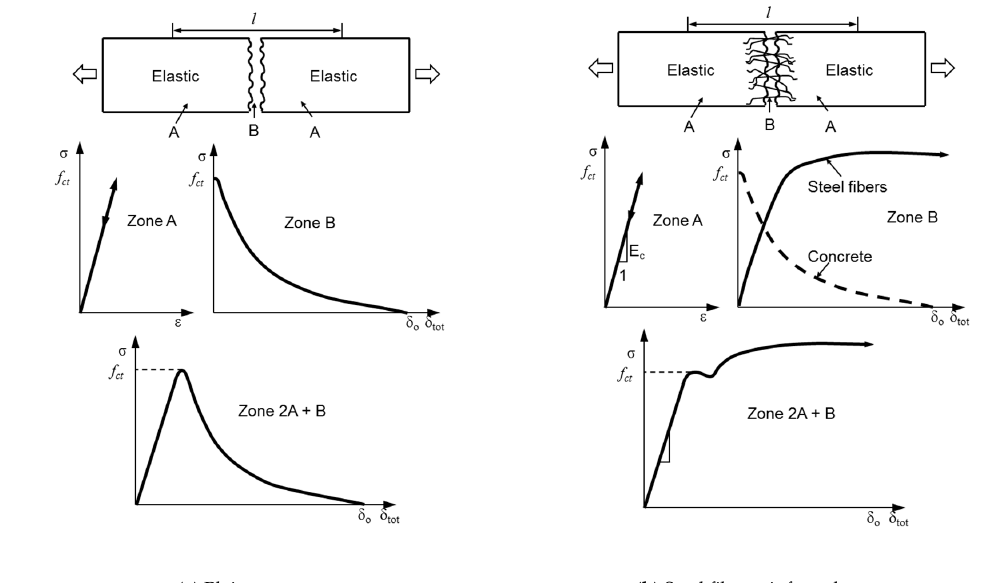
Figure 1. Typical fracture behaviour of plain concrete and SFRC under direct